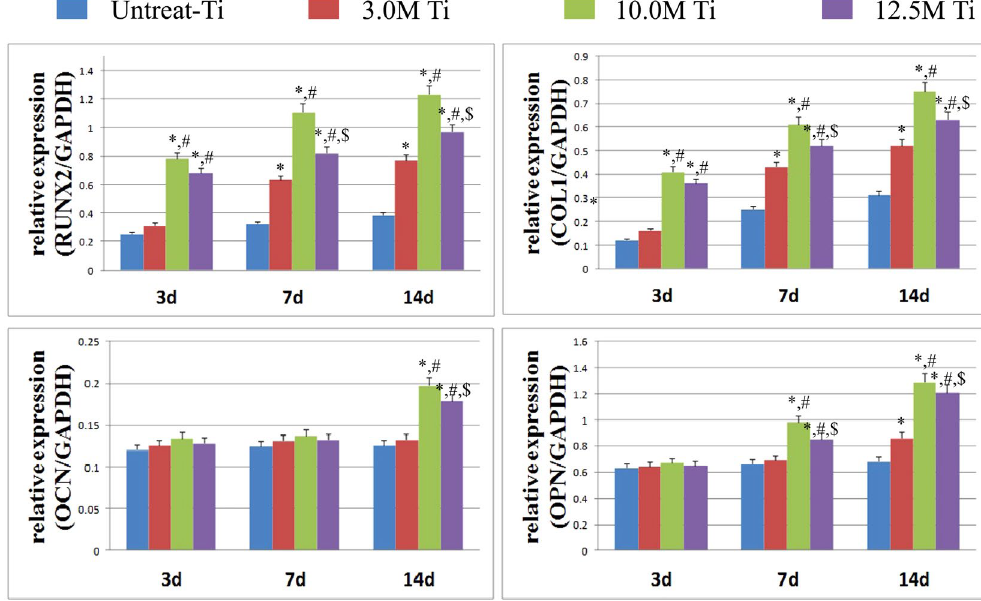
Figure 10. The mRNA expression levels of various osteogenic factors determined by qRT-PCR. * p < 0.05 vs untreated-Ti, # p < 0.05 vs 3.0M-Ti, $ p < 0.05 vs